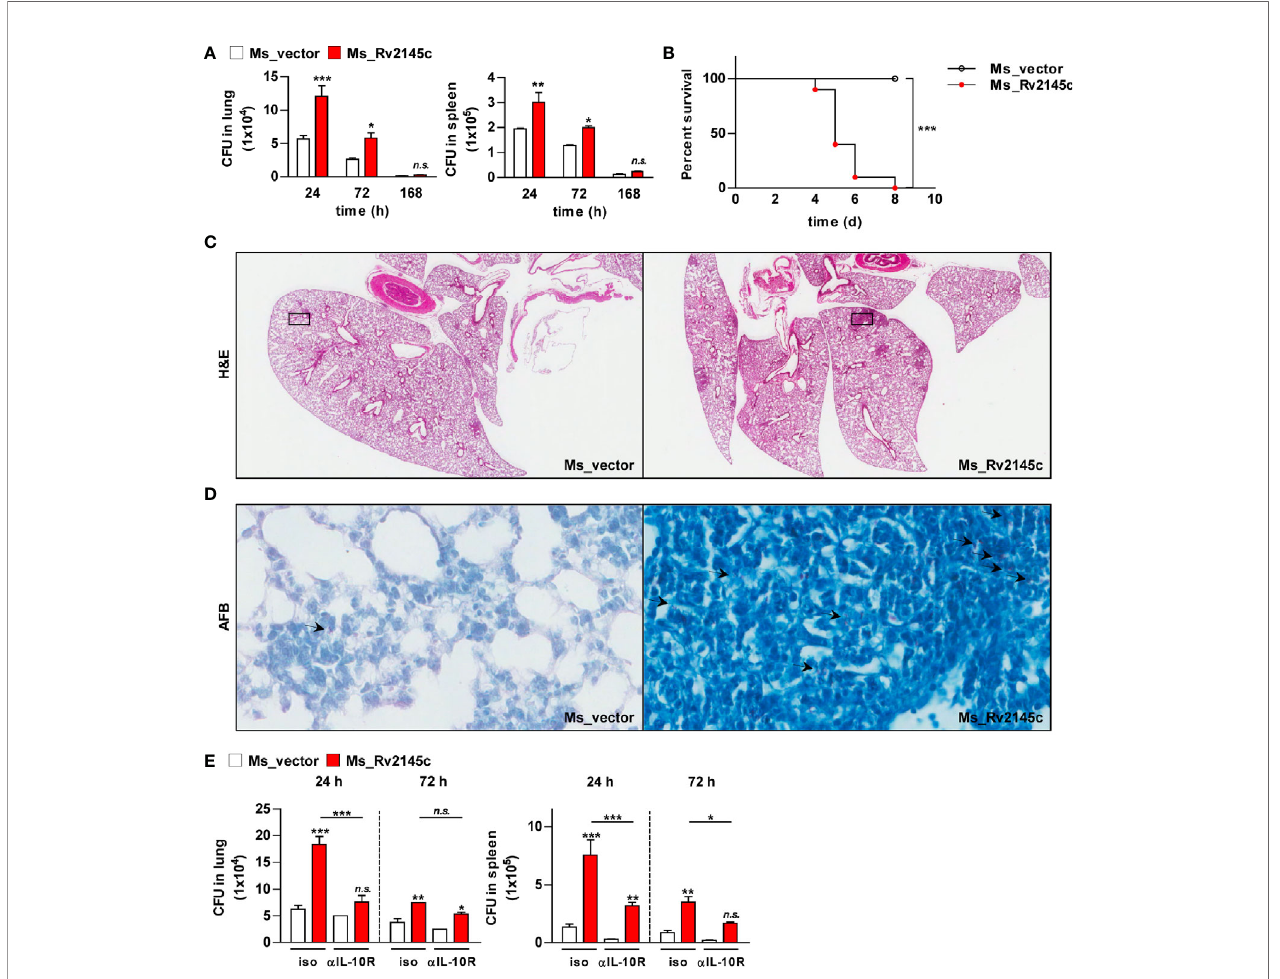
FIGURE 8 | Expression of Rv2145c increases virulence of M. smegmatis in vivo . (A) C57BL/6 mice (n = 3 per group at each time point) were infected intravenously with Ms_vector or Ms_Rv2145c (1 × 10 6 CFU/mouse). Mice were sacri fi ced at the indicated time points (24, 72 and 168 h), CFUs were determined in the lungs and spleens. (B) For the survival test, C57BL/6 mice (n = 5 per group) were infected intravenously at a high dose (1 × 10 7 CFU/mouse). (C, D) The lung tissues of Ms_vector or Ms_Rv2145c strain (1 × 10 6 CFU/mouse)-infected mice were collected at 72 h post infection and stained with (C) hematoxylin and eosin (H&E) and for (D) acid-fast bacilli (AFB). (H&E magni fi cation ×10, AFB magni fi cation ×400). The granuloma area and the bacterial count from a lung section were plotted. (E) C57BL/6 mice (n = 3 per group at each time point) were treated with 1 mg/ml anti-IL-10R antibody or isotype control antibody intraperitoneally, and the next day, they were infected intravenously at a dose of 1 × 10 6 CFU/mouse. Mice were sacri fi ced at the indicated time points (24 and 72 h), and CFUs were determined in the lungs and spleens. The mean ± SD is shown for three independent experiments. * p < 0.05, ** p < 0.01 and *** p < 0.001 compared vector controls or difference between treatment data. Treatments with no signi fi cant effect are indicated as